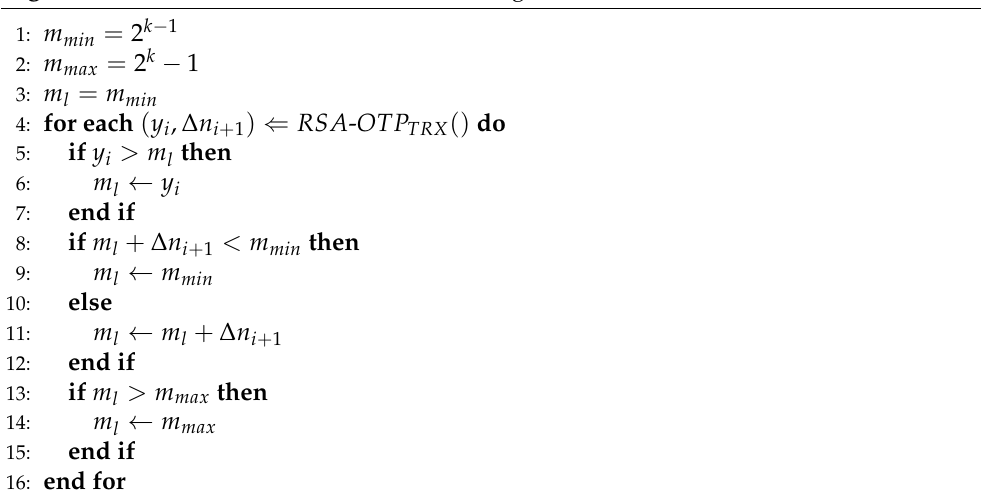
Algorithm 1 k -bit RSA-OTP modulus